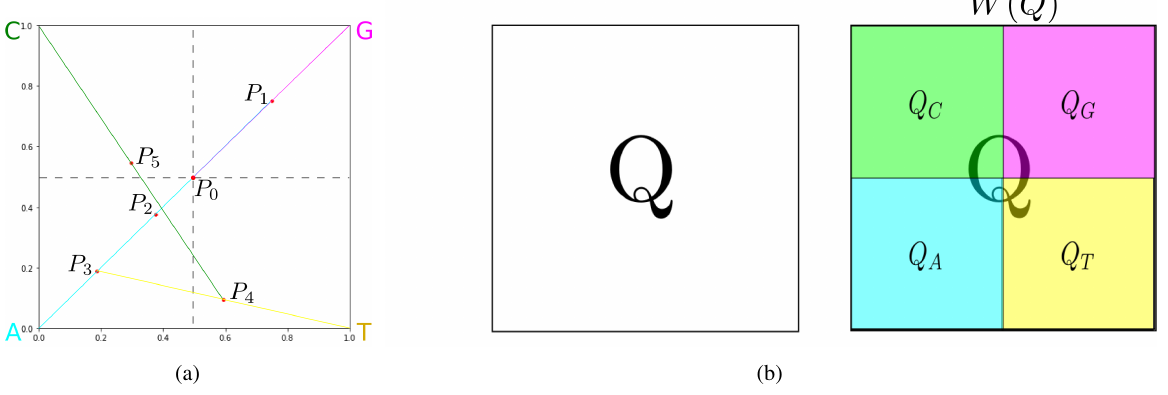
Fig. 3 ( a ) : The CGR of GAATC . ( b ) : Application of the Hutchinson’s operator to the square.